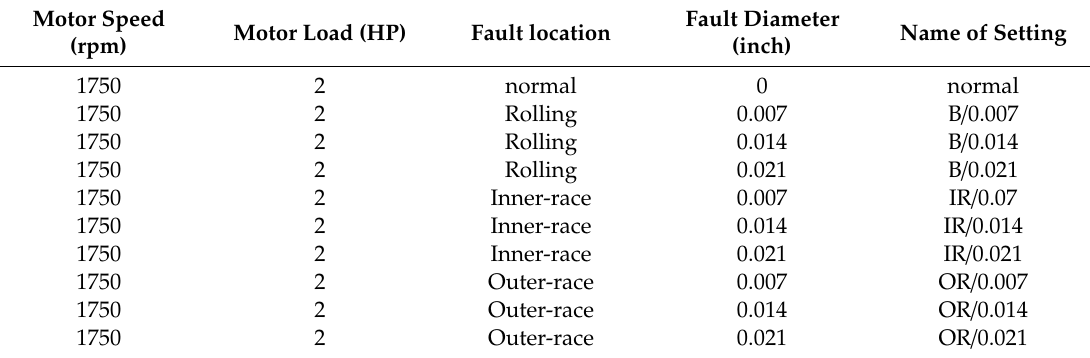
Figure 3. Schematic diagram of rolling ‐ element ‐ bearing fault ‐ simulation experiment (Case I).